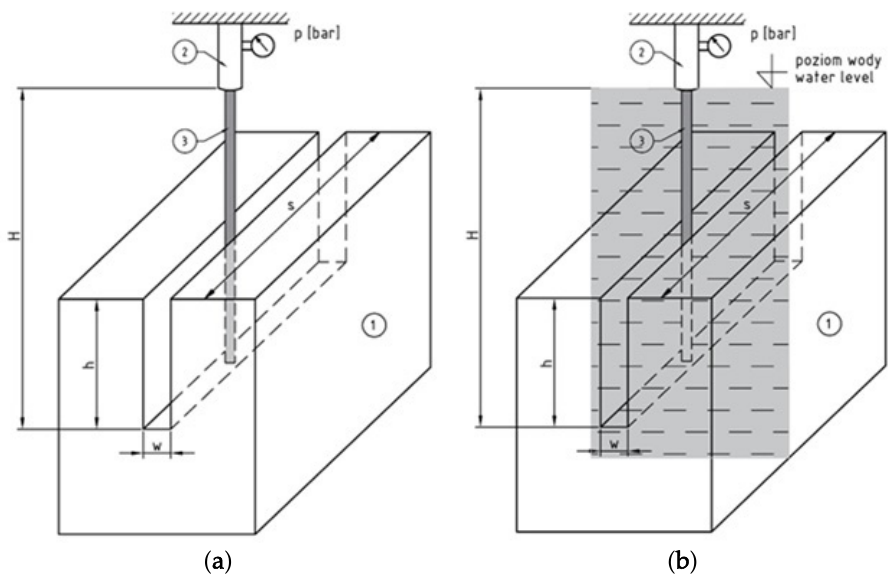
Figure 2. Test stands for cutting out niches in rock samples: ( a ) water jet in the air; ( b ) water jet in water; 1—rock sample; 2—water nozzle; 3—water jet.